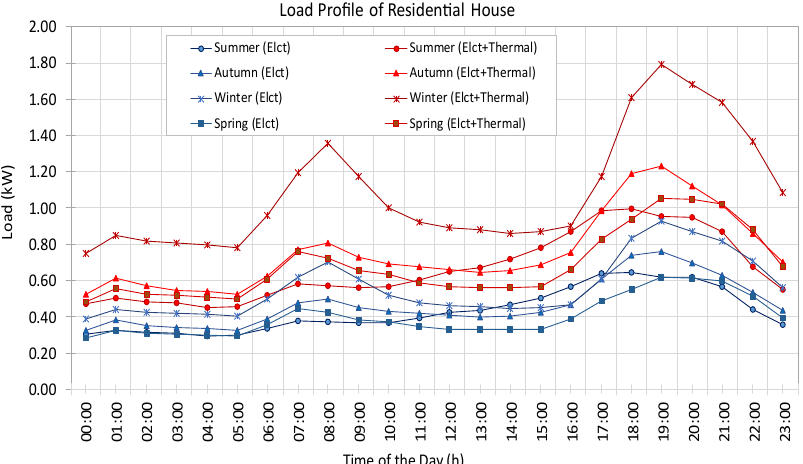
Fig. 2. Residential Building Load pro fi le with seasonal variation.